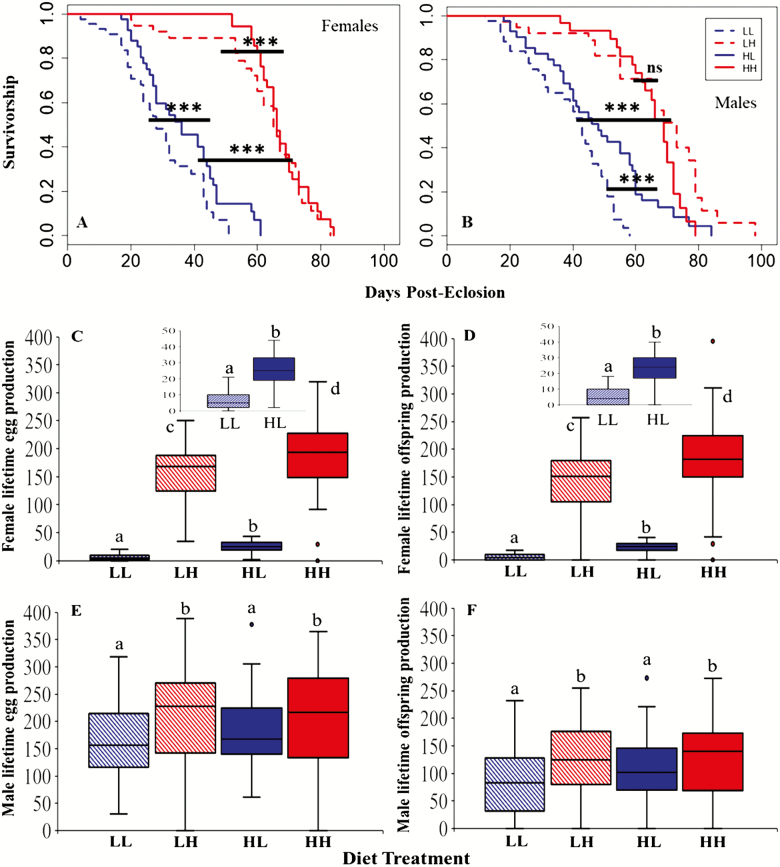
Survivorship and lifetime reproductive success for females and males subjected to LL, LH, HL, and HH diet treatments. LL = constant low yeast (20% SYA); HH = constant high yeast (120% SYA); LH = low yeast larval and high yeast adult diet; HL = high yeast larval and low yeast adult diet. Low or high yeast larval diet (dashed or solid line, respectively) and low or high protein adult diet (blue or red, respectively). Female (A) and male (B) survival, against time in days since eclosion (n = 45 per treatment: median survival of females in days (interquartile range) LL = 27 (18) ,HH = 66 (9), LH = 65 (17), HL = 32 (20); median survival of males in days (interquartile range) LL = 41 (22), HH = 66 (12), LH = 66 (30), HL = 46 (24)). Stars indicate significant differences (*** p < .001). Lifetime reproductive success for females (C = eggs; D = offspring) and males (E = eggs; F = offspring). Lifetime reproductive success (LRS) for females was calculated from the sum of weekly 24 hours counts of eggs or offspring, for each of the 45 females for each diet treatment. LRS for males was calculated from the sum of weekly 24 hours counts of eggs or offspring produced by standard wild-type (WT) females mated to the focal males, for each diet treatment group. The insets show the LRS for the two low yeast adult diet treatments (LL and HL) in each case. Letters indicate significant differences.